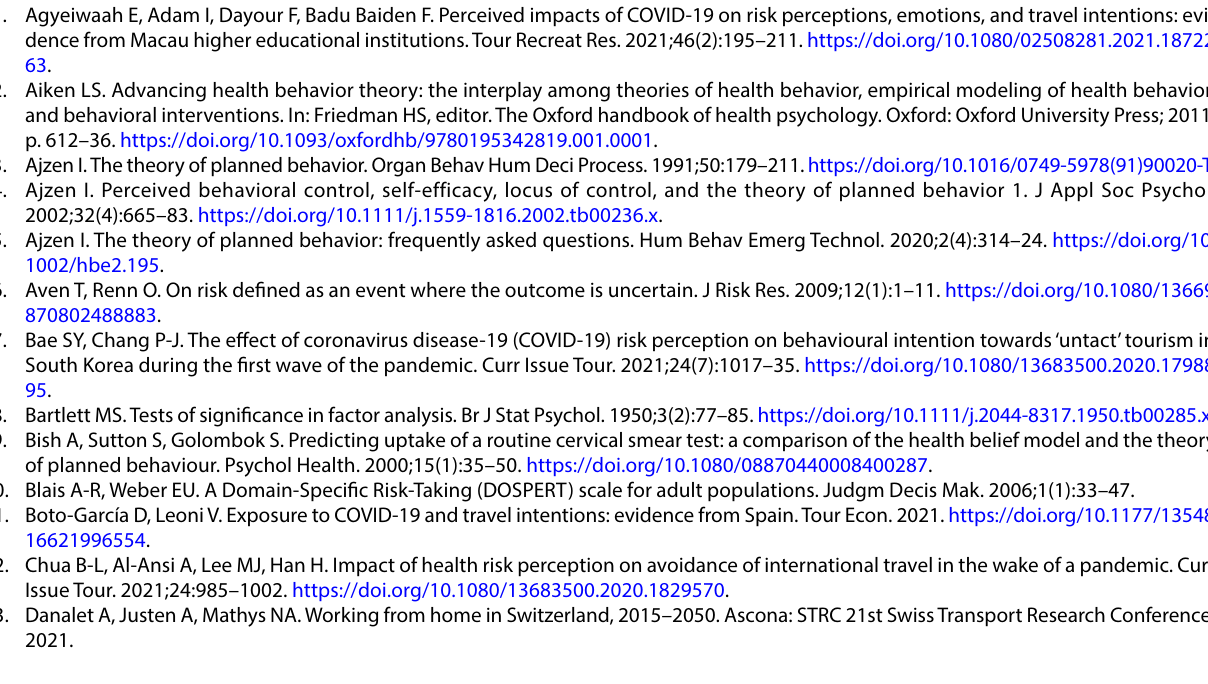
n = 1568, Bootstrap samples: 2000; Sampling: simple resampling b non-standardised coefficients; bias bias of the parameters; SE standard errors, CI confidence interval; LL lower limit; UL upper limit; p p-value, Bca bias corrected